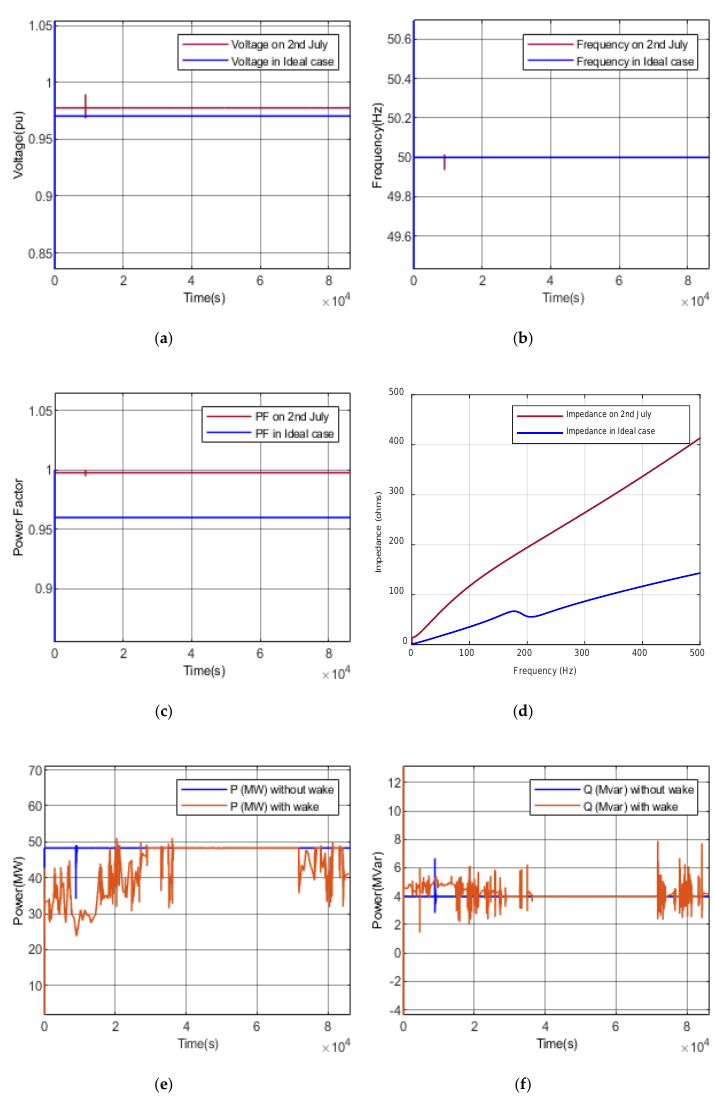
Figure 7. Case-1, Scenario 4: ( a ) Voltage (V) at PCC; ( b ) frequency (F) at PCC; ( c ) PF at PCC; ( d ) Impedance (Z) vs. F; ( e ) P-trend; and ( f )